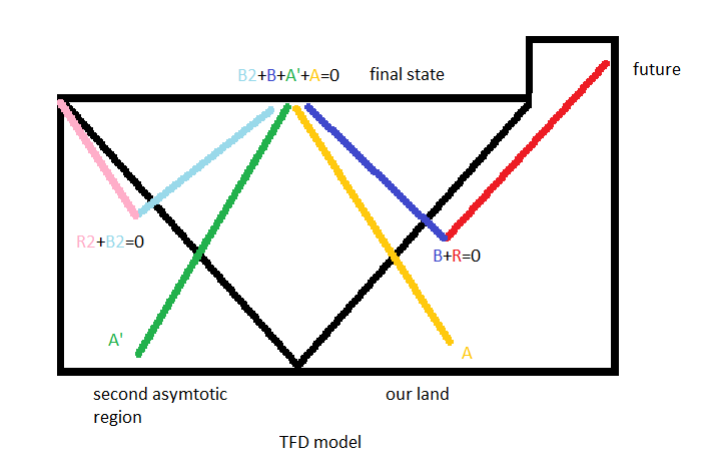
Figure 2. Thermofield double